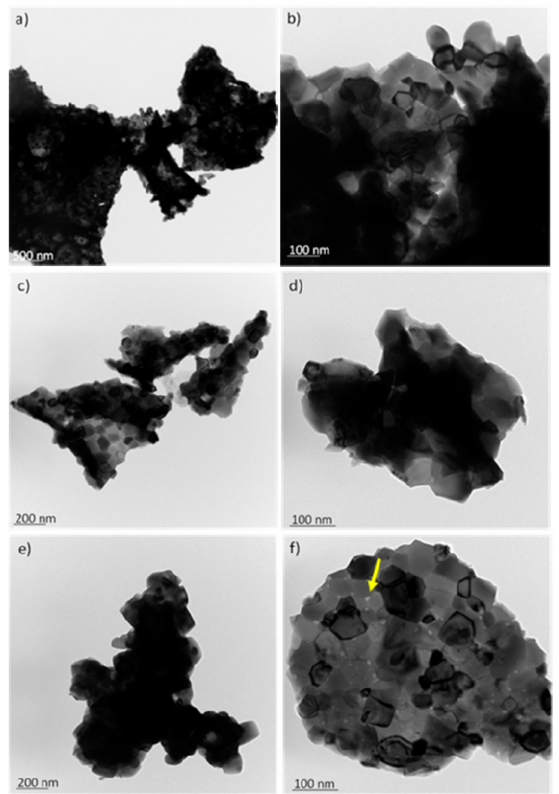
Figure 2. Transmission electron microscopy images with different magnifications of Ni nanoparticles supported on Ce-Sm-xCu catalysts: ( a,b ) 5% Cu; ( c,d ) 7% Cu; ( e,f ) 10%